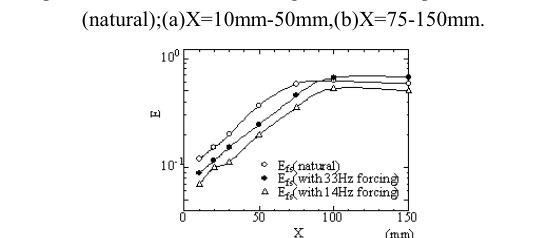
Fig. 20 Amplitude distribution of starting vortex fs component of u-fluctuation